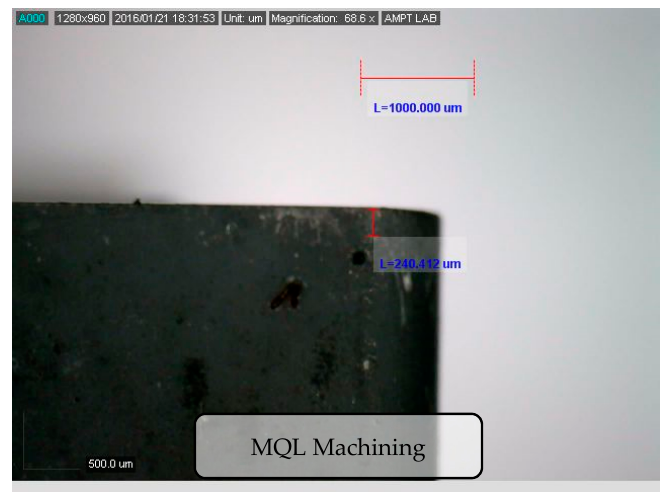
Figure 6. No built-up edge (Experiment no-11).